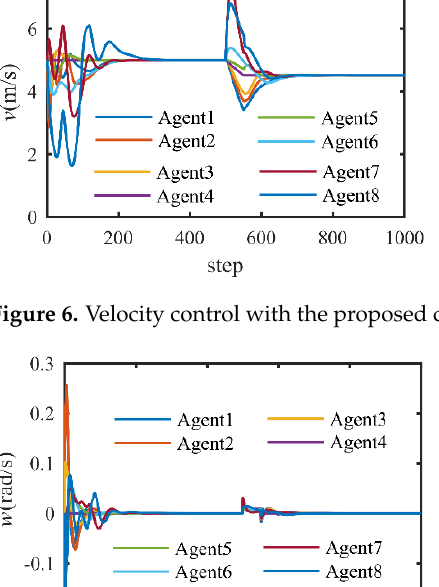
Figure 5. Angular rate control result with linear controller.